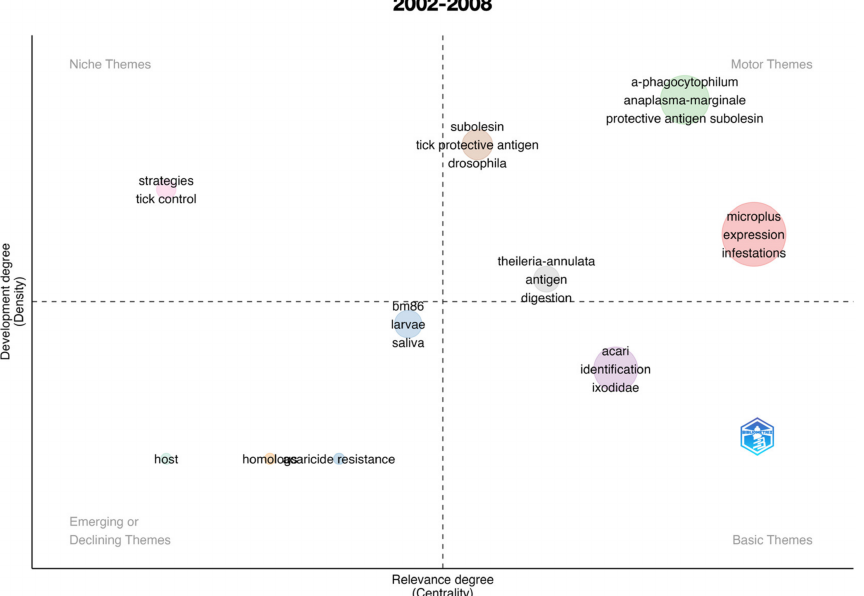
Figure 4. Thematic roles of the documents published on the topic “anti–tick vaccination” in the period